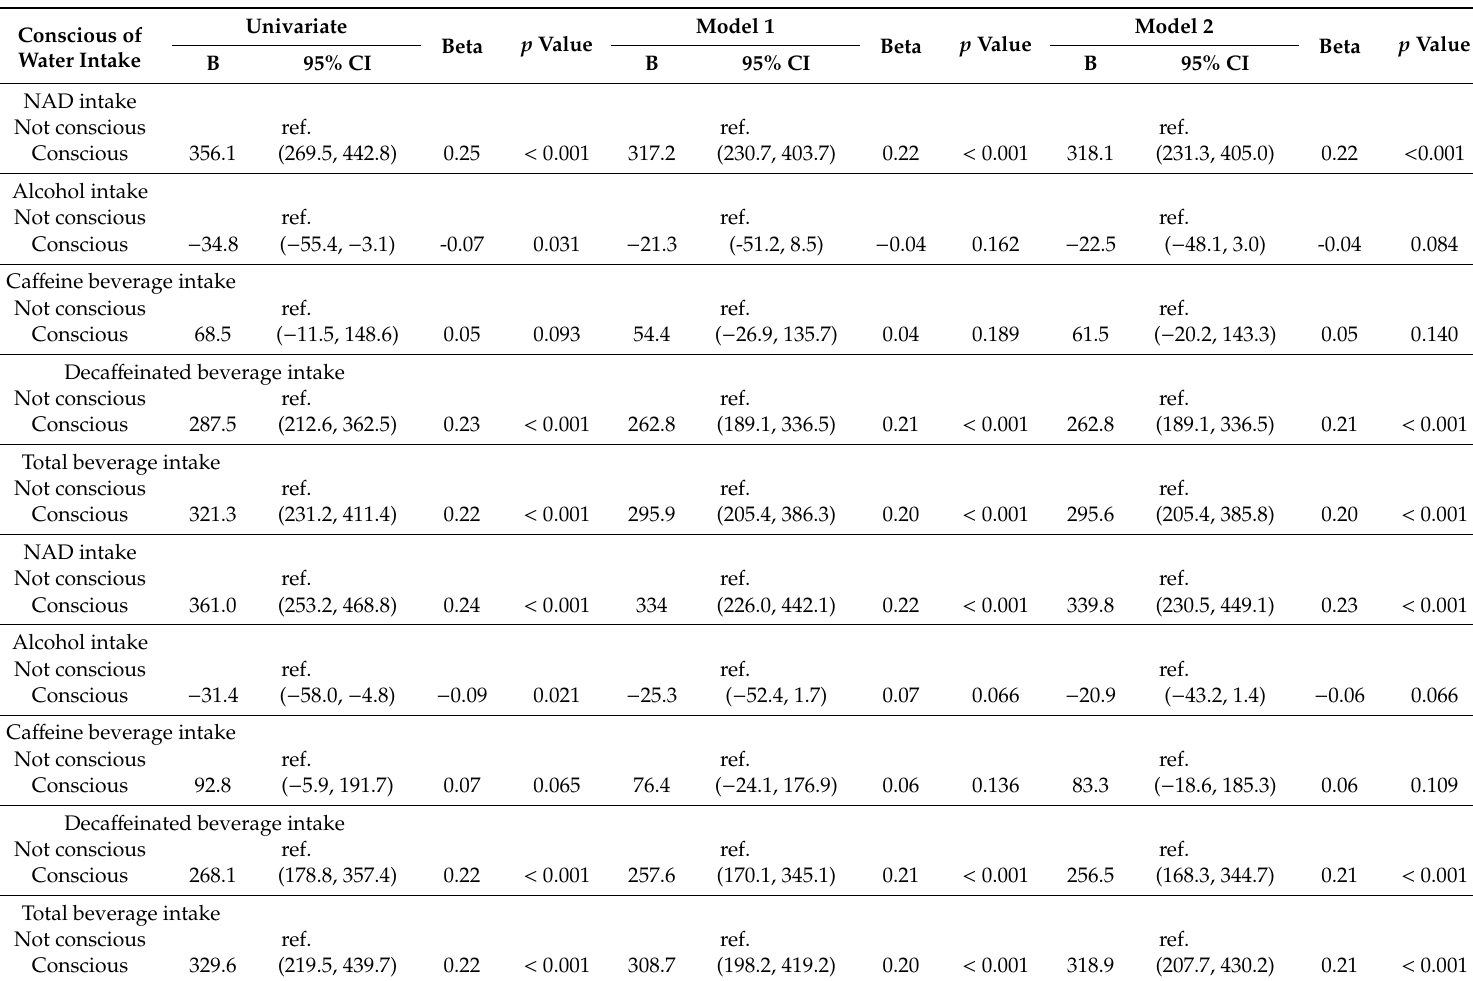
Table 4. Association between being conscious of water intake and the amount of beverages intake: Uni- and multivariate linear regression analyses. Conscious of Water Intake